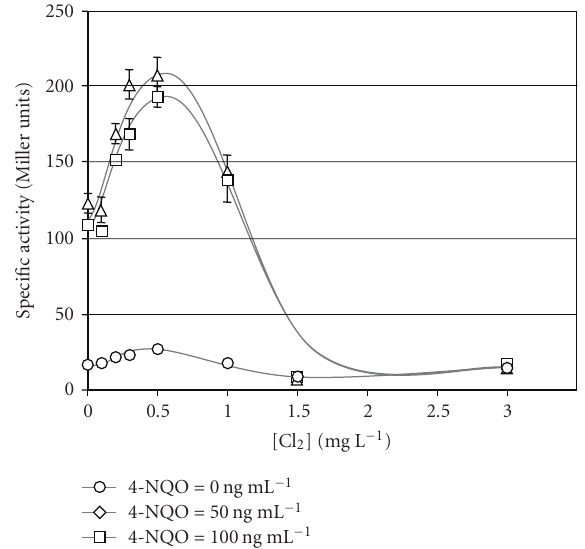
Figure 3: Specific activity of the β -galactosidase of Salmonella typhimurium exposed to chlorine or chlorine and